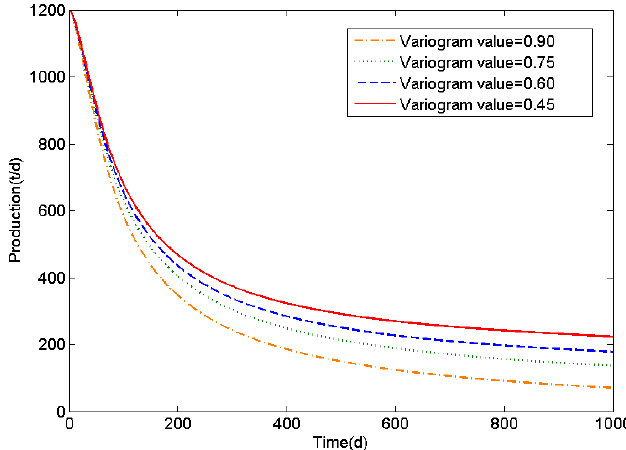
Figure 5. Production with different variogram values.